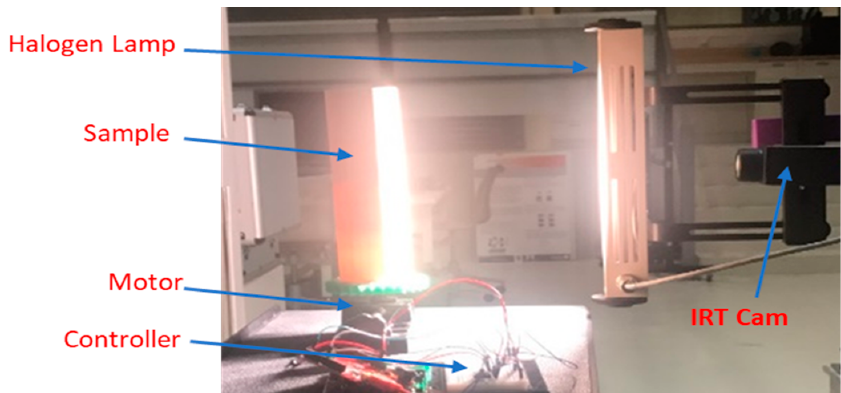
Figure 10. Fixed scan experiment testbed.